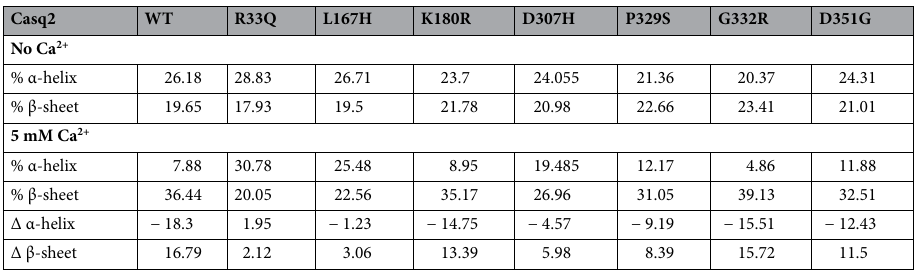
Table 1. CD analysis of calsequestrin mutants. WT,